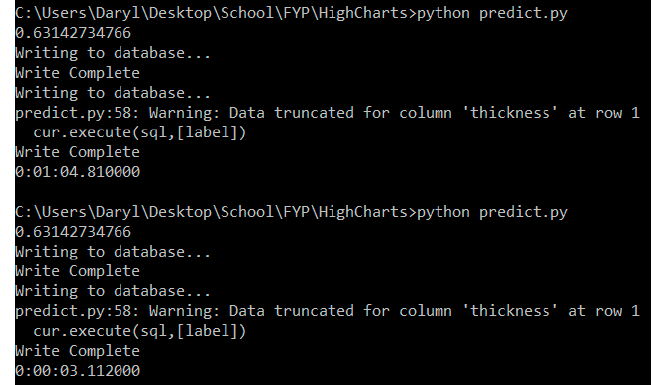
Figure 20. The AML prediction speed of the Python script.